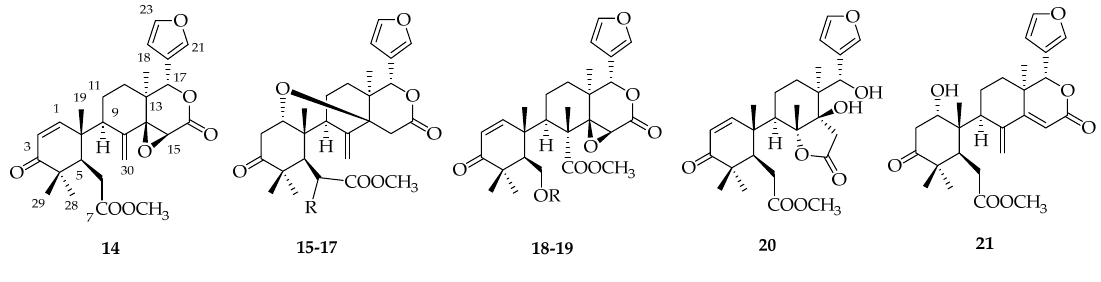
Figure 3. Chemical structures of andirobin ‐ type limonoids 14 – 21 . Table 2. Structures and sources of andirobin ‐ type limonoids 14 – 21 .